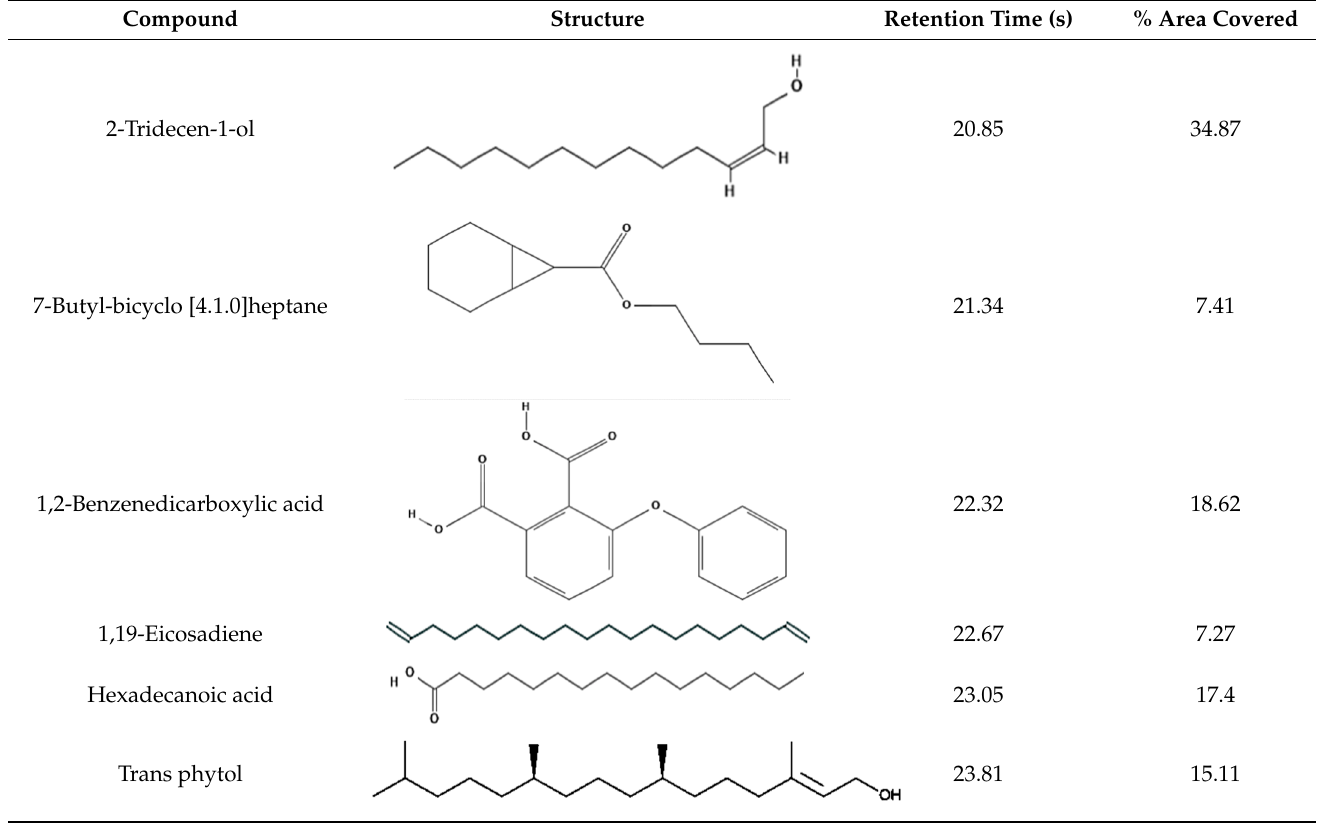
Table 2. Photochemical present in MeOH extract of shoots of M. sinaica.